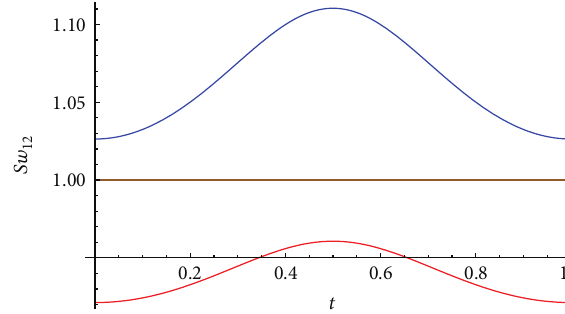
Figure 11: Stability function of the 2-cycle {𝑤 1 (𝛼),𝑤 2 (𝛼)} for 𝐶 1 and 𝐶